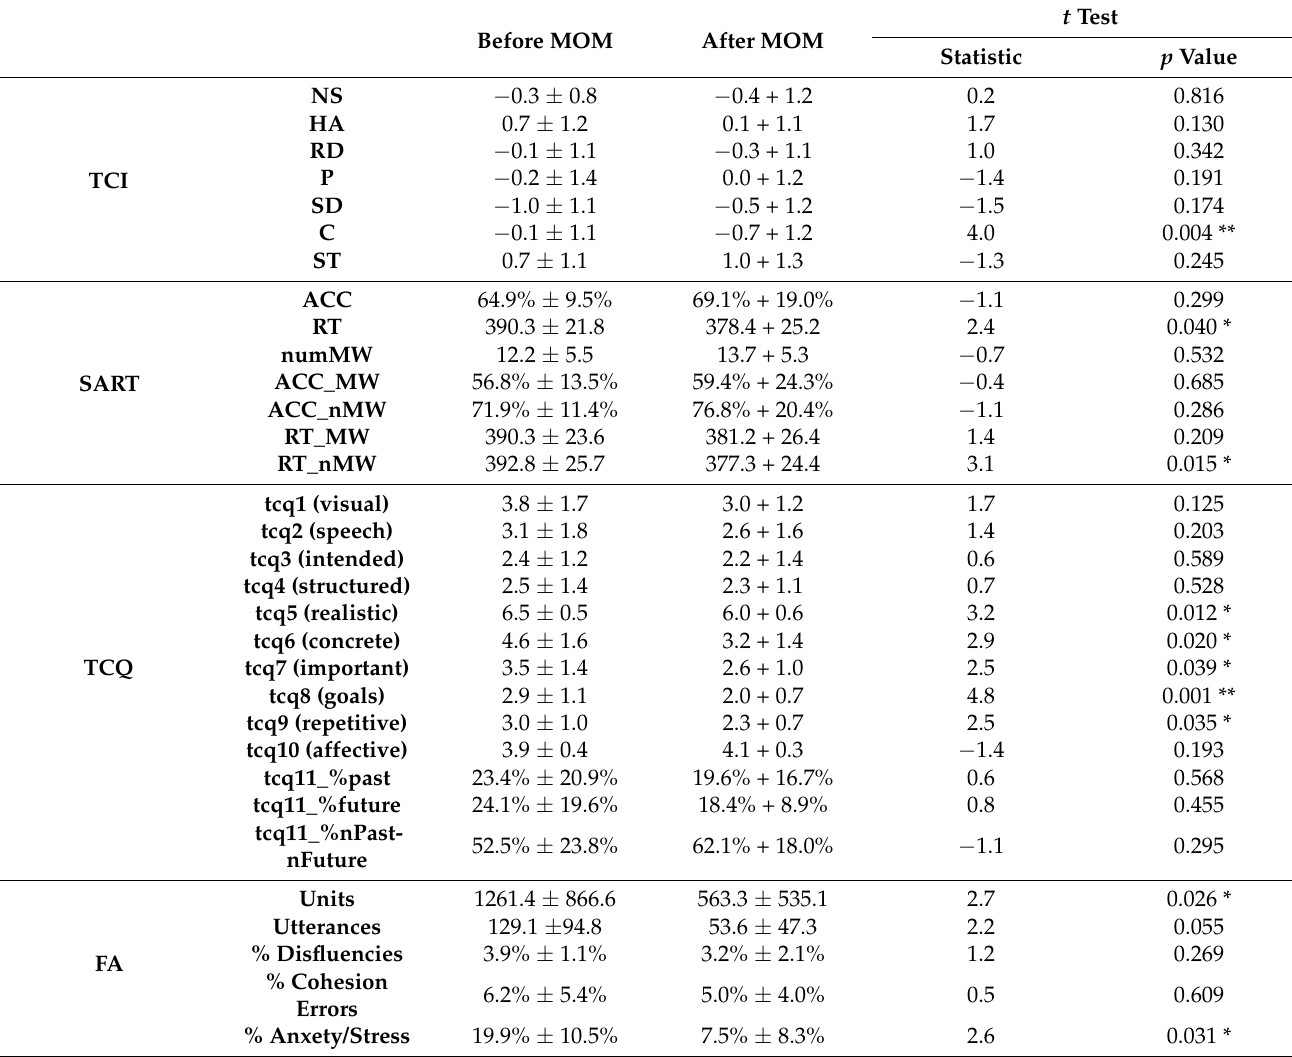
Table 1. Descriptive statistics of data obtained before and after the MOM training and results of paired t tests for each pair of